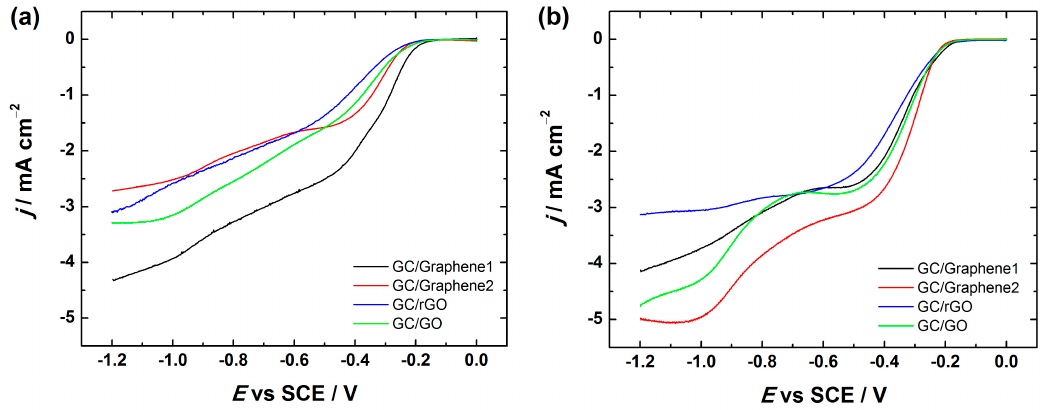
Figure 10. RDE voltammetry curves for O 2 reduction on GC electrodes coated with graphene nanopowder from Graphene Supermarket (Graphene1), graphene nanoplatelet aggregates from Strem Chemicals (Graphene2), reduced graphene oxide (rGO) and graphene oxide (GO) in O 2 ‐ saturated 0.1 M KOH; ω = 1900 rpm, ν = 10 mV ∙ s − 1 . The electrodes were prepared using the catalyst ink suspension in: ( a ) 2 ‐ propanol containing OH − ionomer; and ( b ) DMF ( N , N ‐ dimethylformamide).